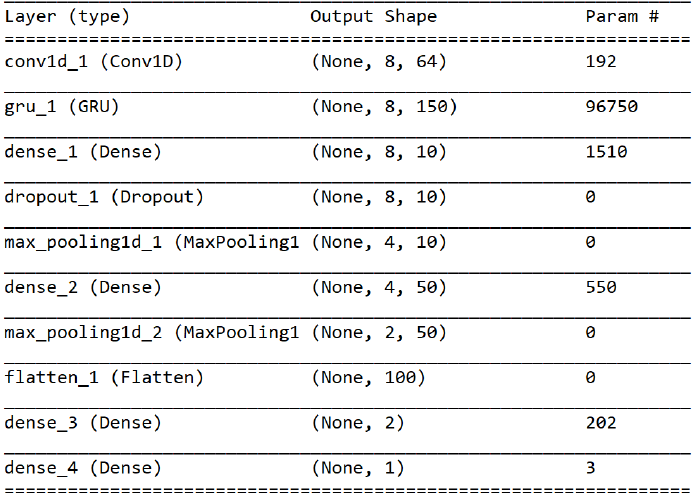
Figure 5. Output shape of tuned Convolutional Neural Network (CNN)